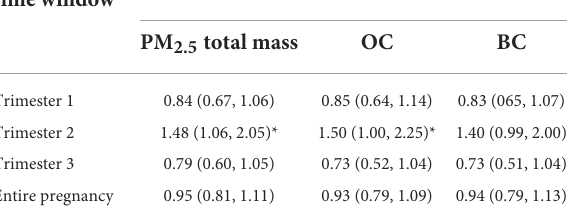
TABLE 3 Associations of total PM 2.5 mass and exposure to two carbon constituents with the risk of preterm birth. Exposure